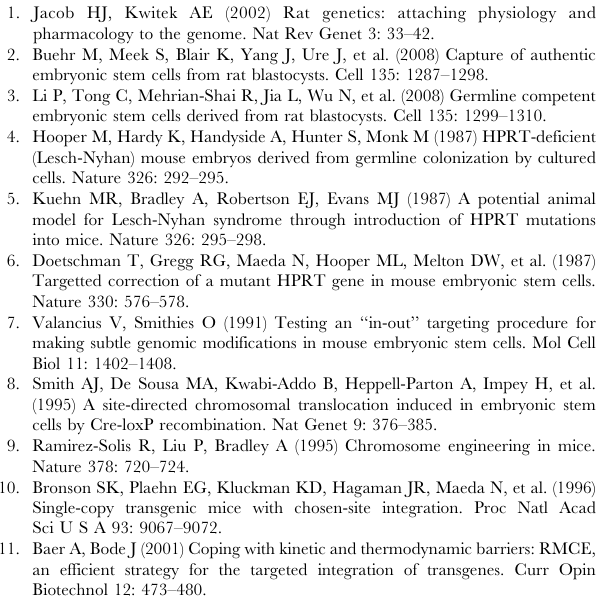
Table S1 Effect of Oxygen levels on rat ES cell growth. Table S2 RT-PCR